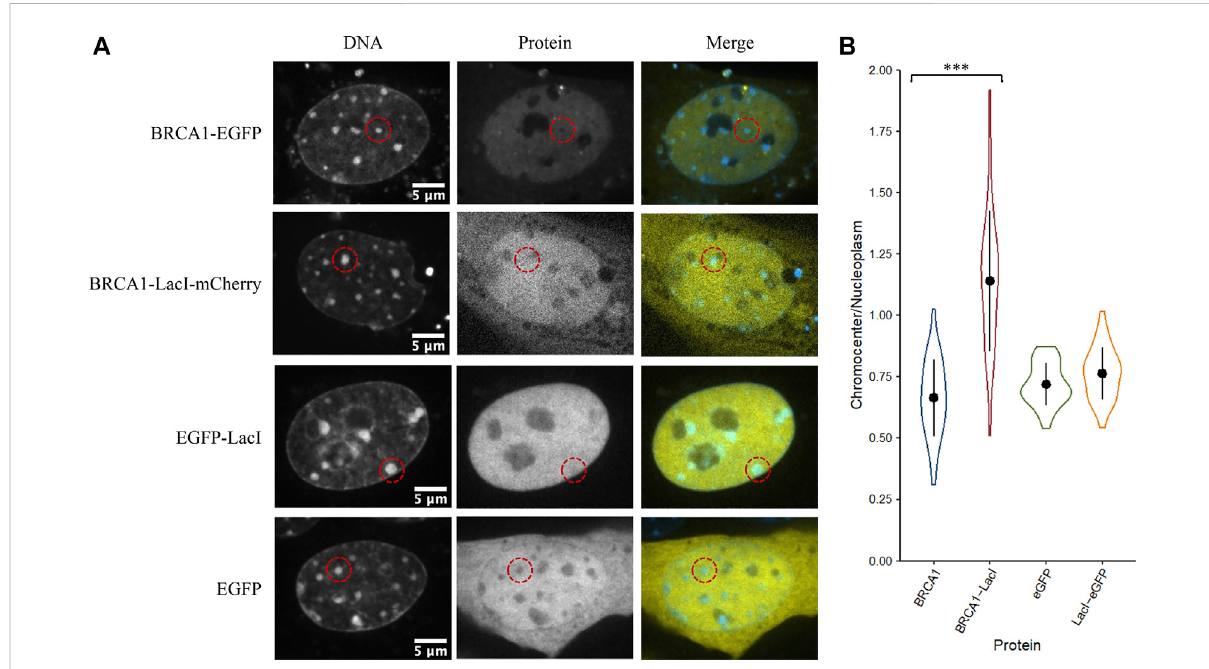
FIGURE 5 The LacI DNA binding domain may alter the ability of BRCA1 to access chromocenters. (A) CH3/10T1/2 cells were stained with Hoechst 33342to visualize DNAand transfected with plasmidsencodingeither BRCA1-GFP, BRCA1-LacI-mCherry, LacI-EGFP,or EGFP. (B) Quanti fi cationof relative chromocenter intensity for each protein. BRCA1-EGFP is signi fi cantly different from BRCA1-LacI-mCherry ( p = 1.3E − 09). EGFP is not signi fi cantly different from LacI-EGFP ( p = 0.088) ( n = 30 for each